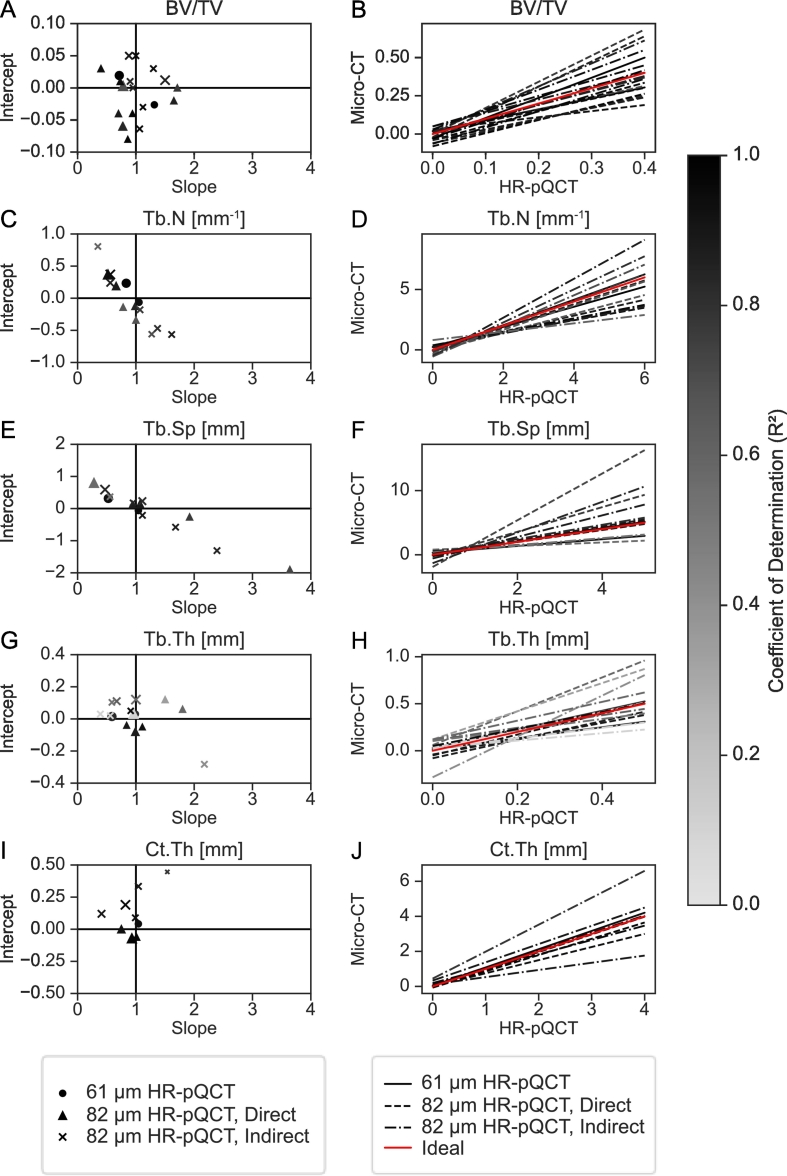
Linear regression analysis shows large variation across studies in the most commonly reported morphometric parameters, which were reported in more than ten studies. (A, C, E, G, I) Scatter plots of slope vs intercept for 61 μm HR-pQCT and 82 μm HR-pQCT validated against micro-CT show variability between parameters. Results from 82 μm HR-pQCT studies are further divided into direct and indirect approaches for all parameters. Grey-levels indicate the corresponding coefficient of determination (R2), while marker size indicates the voxel size of the micro-CT data used for comparison. (B, D, F, H, J) Linear regression lines from the same regression analyses are shown. The red, ideal line, indicates a perfect match between HR-pQCT and micro-CT and has slope of one and intercept of zero. In general, we observe that the parameters that have higher average coefficient of determination (e.g. BV/TV, Ct.Th) exhibit either under- or overestimation throughout the entire parameter space. In contrast, the parameter with the lowest coefficient of determination (e.g. Tb.Th) does not show a clear trend across studies. Furthermore, Tb.N and Tb.Sp have a consistent turning point between over- and underestimation across all studies.